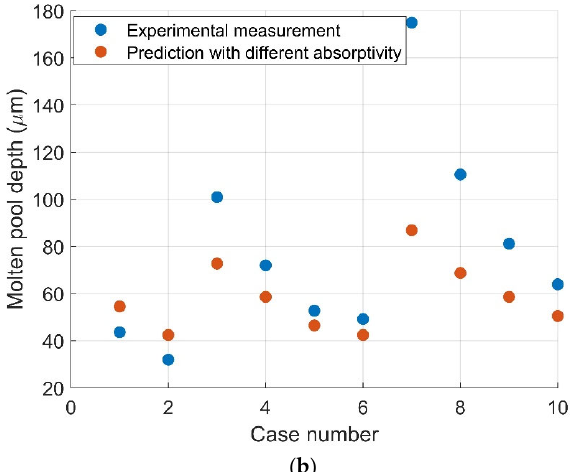
Figure 2. Comparison of predicted molten pool size with experimental data. ( a ): Molten pool width. ( b ): Molten pool depth.